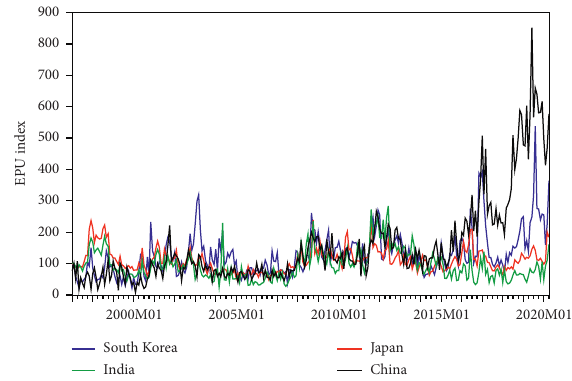
Figure 1: The relationship between the EPU indices Table 1: Descriptive statistics.